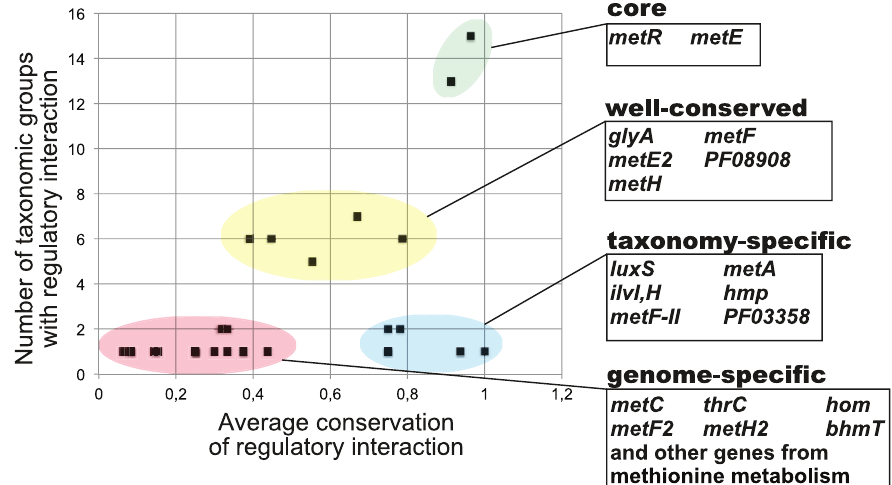
Figure 3. Conservation of regulatory interactions in the reconstructed MetR regulons. The core regulon, taxon- and genome-specific regulon members are highlighted and listed along with their average conservation scores and functional annotations in Table